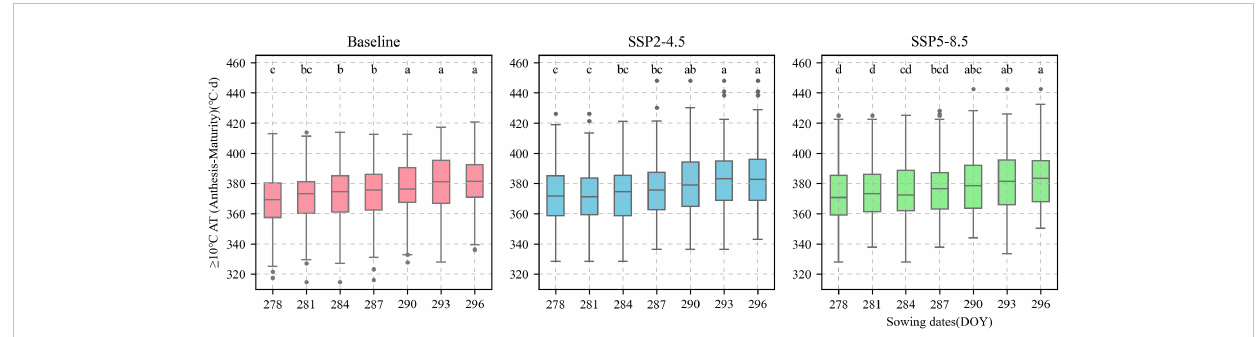
FIGURE 13 Accumulated temperature of ≥ 10°C from anthesis to maturity of 81 wheat varieties under different sowing dates. Current sowing date (DOY 284). Red boxes represent baseline. Blue boxes represent SSP2-4.5. Green boxes represent SSP2-8.5.